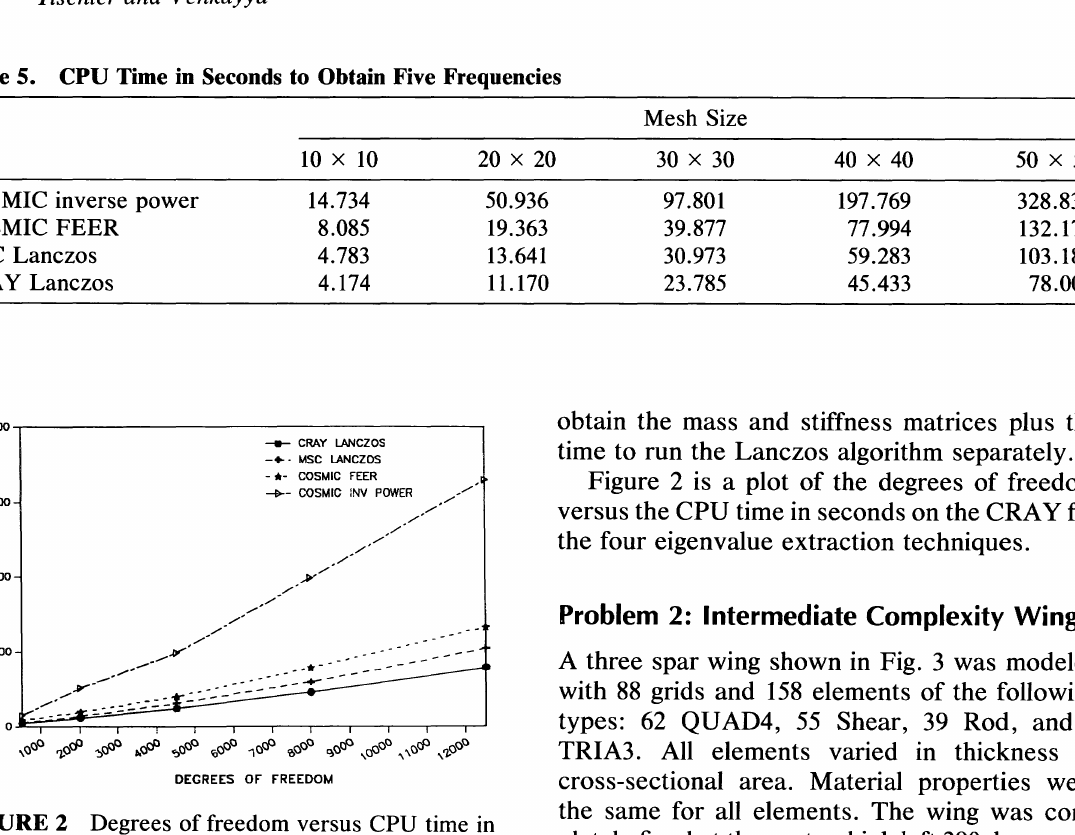
FIGURE 2 Degrees of freedom versus CPU time in seconds.